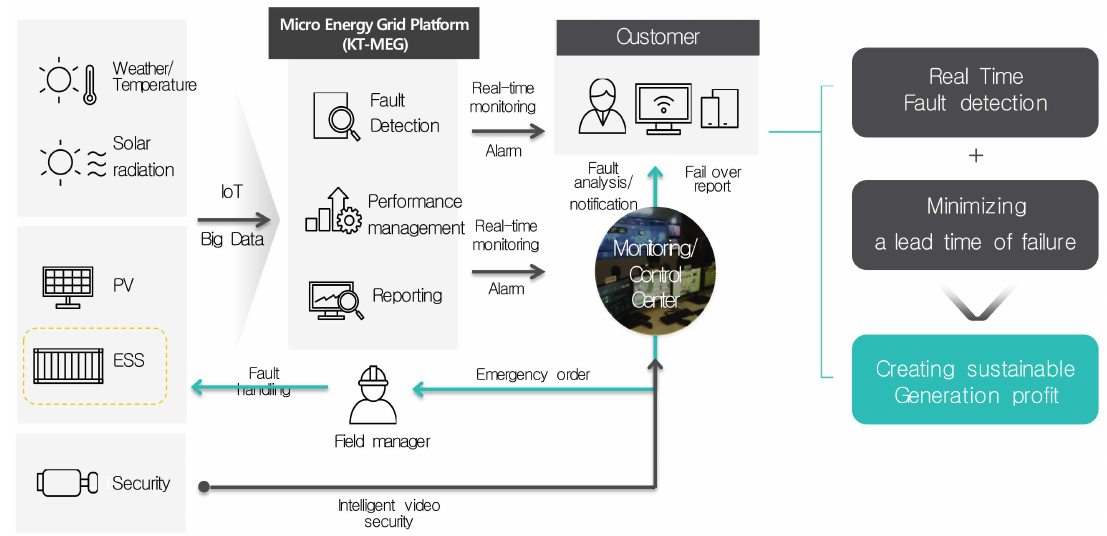
Figure 13. Conceptual diagram of photovoltaic (PV) operation and management (O&M)